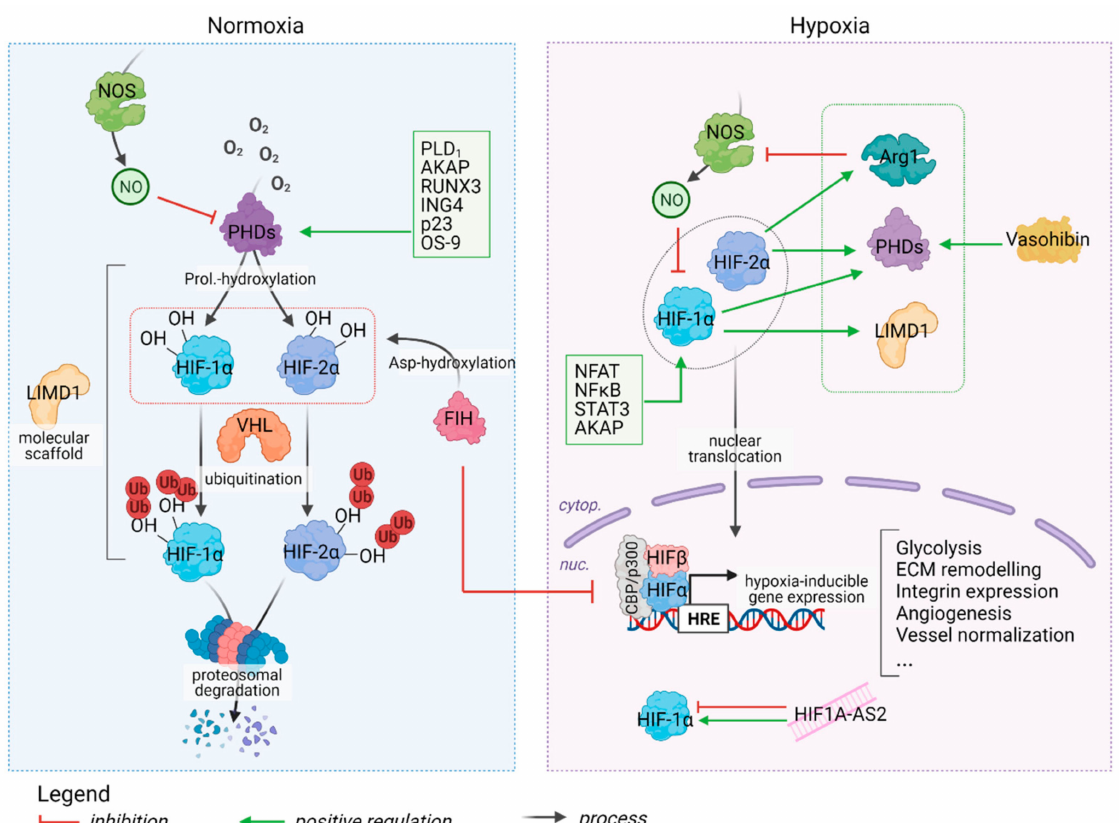
Figure 1. Hypoxia pathway proteins–a regulatory network. Under normoxic conditions, PHDs 1–3 can preferentially hydroxylate HIF1 α or 2 α , which leads to their VHL-mediated degradation. FIH preferentially hydroxylates HIF1 α rather than HIF2 α , preventing necessary interaction with co-factors [6,8]. Additionally, LIMD1, a scaffold protein that helps assemble the complex with VHL [9,10] and numerous other regulators of PHD expression/activity have been described (green box—Normoxia [11–17]). During hypoxia-associated events, including inflammation or tumor growth, HIF1 is activated (green box—Hypoxia), on the other hand, HIF1 supports the transcription of PHD, LIMD1, and Nitric Oxide synthase (NOS), which in turn inhibit HIF1 activity. HIF2 can induce the expression of Arginase 1, which competes with NOS for the same substrate, thus reducing NO production efficiency and reducing HIF1 inactivation as well [9,10,18–21]. HIF1 α -AS2 promotes HIF1 transcription only in the first few hours after hypoxia induction but subsequently inhibits HIF1 activity; in contrast, HIF1 α -AS2 continues to promote HIF2 expression even after several hours of hypoxia